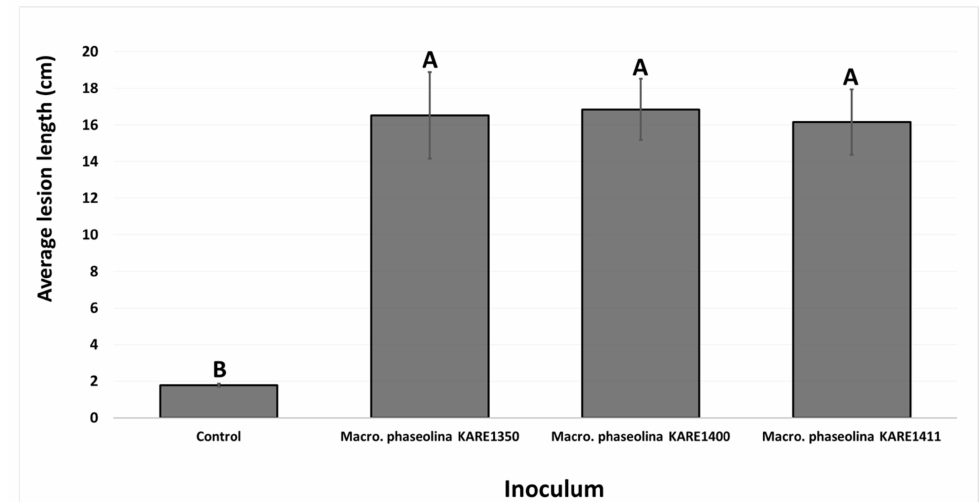
Figure 7. Average lesion lengths (cm) on pistachio clonal UCBI rootstocks 10 months after inoculation with mycelial plugs of Macrophomina phaseolina isolates KARE1350, KARE1400, and KARE1411 (July 2017 inoculations). Columns with di ff erent letters indicate treatment means that are significantly di ff erent ( p < 0.00001).